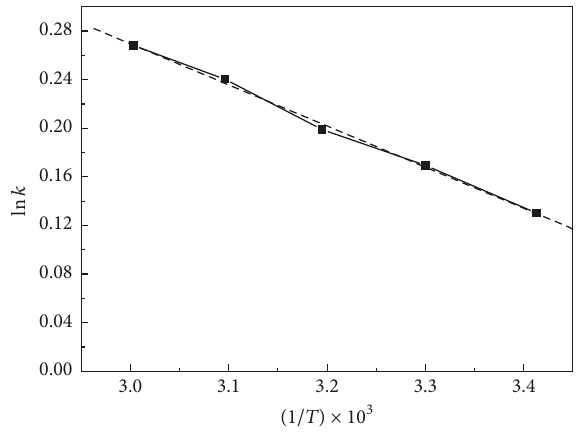
Figure 8: The relationship between VSS biodegradation rate and aeration rate. — ◼ — regression coefficient of 0.9943 for 𝑛 ; ------